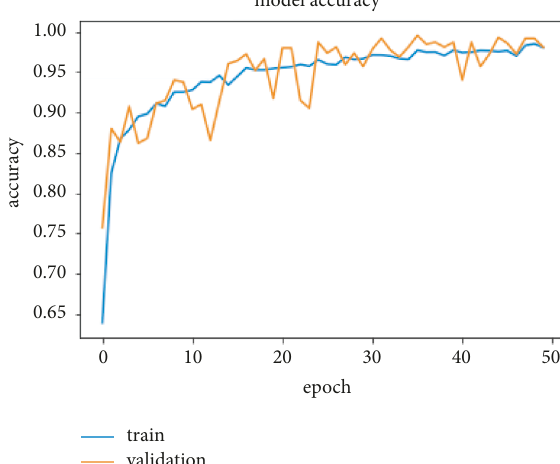
Figure 4: Accuracy of the model during training and validation